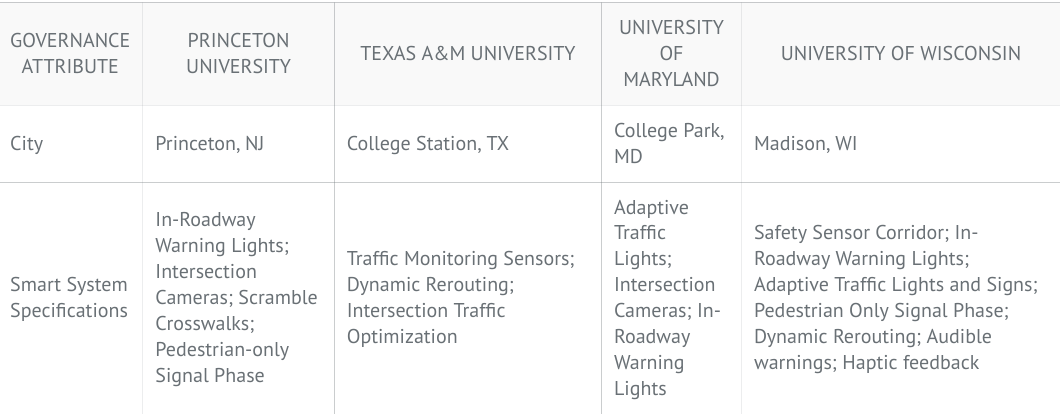
TABLE 1: Governance comparison across four smart intersections